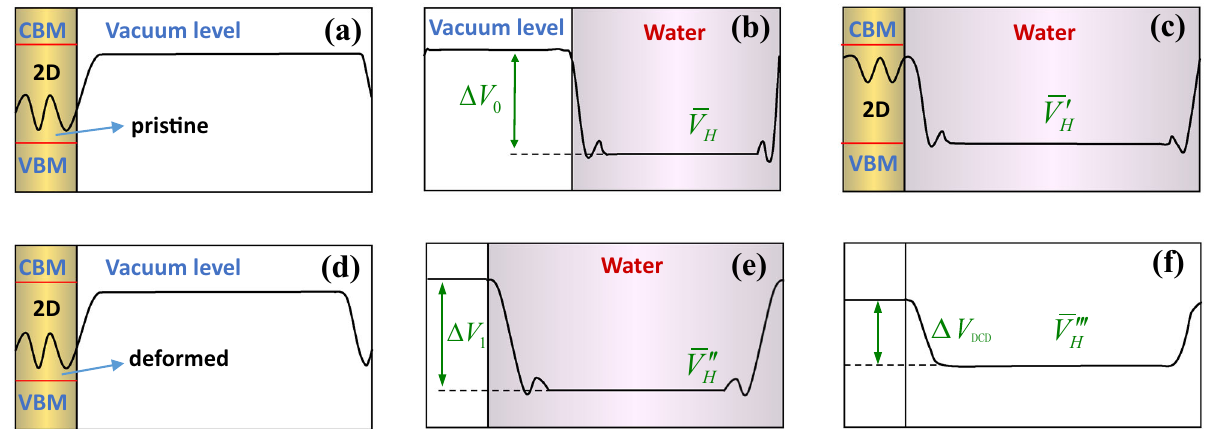
Fig. 1 Schematics for analyzing the band alignment and band edge shift. a The band edge of pristine 2D material relative to the vacuum level. b The averaged electrostatic potential of bulk water V H relative to the vacuum level, resulting in Δ V 0 . c The band edge of 2D material in 0 , which is aligned with V H . d The band edge of deformed the combined 2D material/water system, where the AEP in the bulk water region is V H 2D material relative to the vacuum level. e The AEP of the water part extracted from the combined 2D material/water system. Δ V 1 is the corresponding averaged electrostatic potential difference between 2D material region and bulk water region. f The AEP generated from the 000 is the AEP of bulk water region and Δ V DCD is the difference between differential charge density of the combined 2D material/water system. V H 000 the AEP of 2D material region and V H